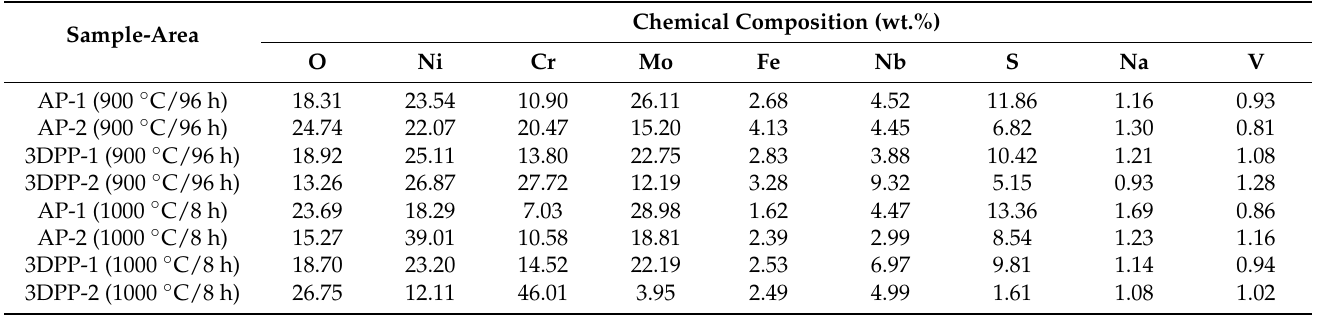
Table 4. Chemical composition measured by EDS in two areas from corrosive layer. Sample-Area